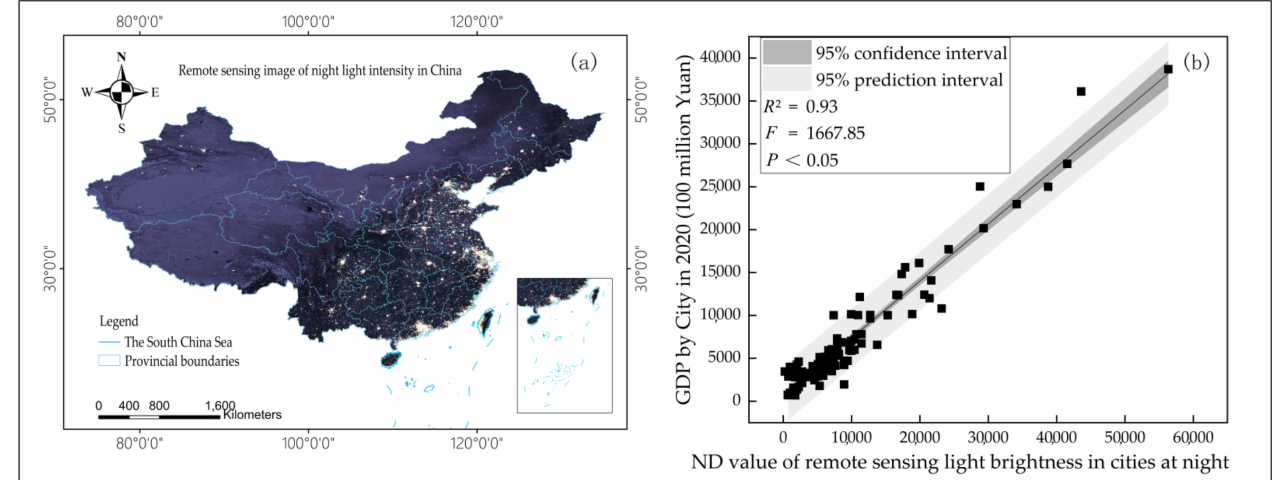
Figure 6. ( a ) Night light remote sensing image of China; ( b ) Regression model of DMSP/OLS and Gross Domestic Product of Chinese